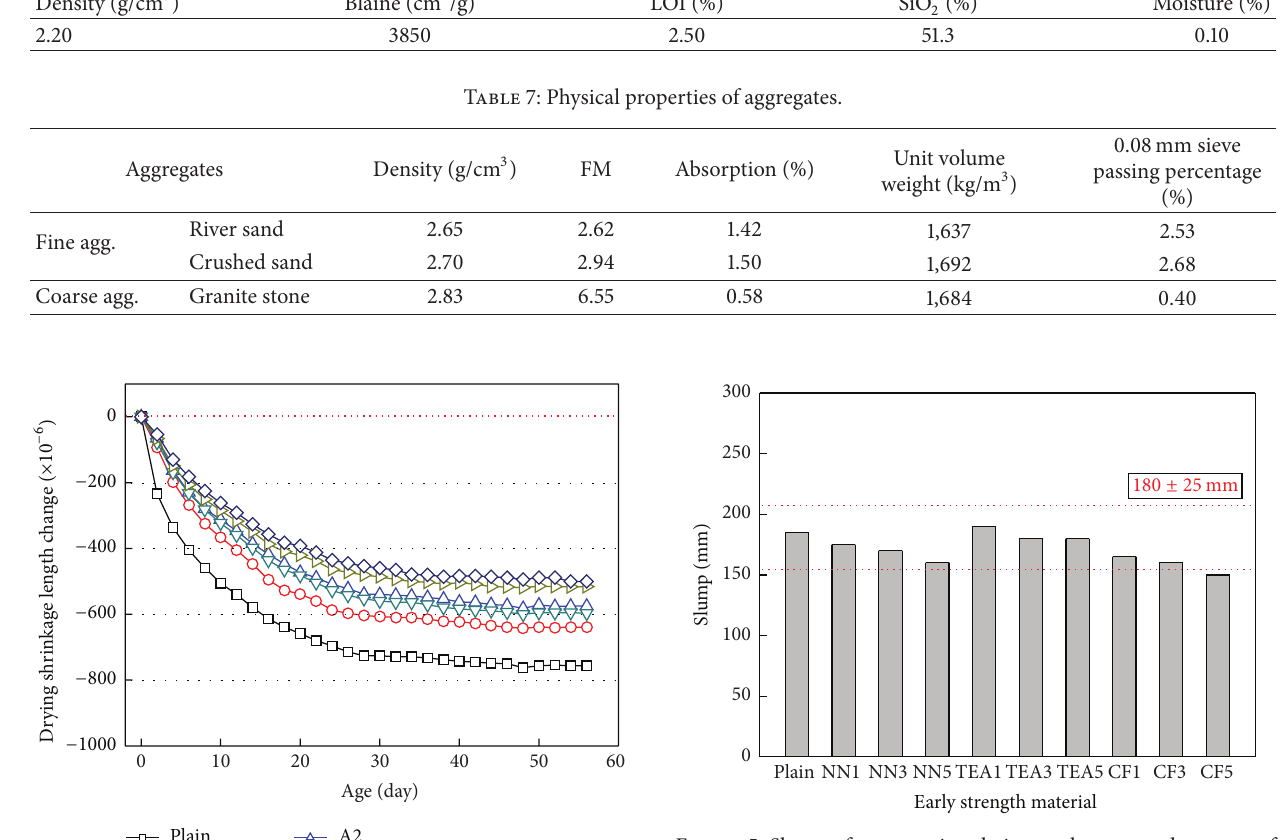
Figure 5: Slump of concrete in relation to the type and amount of early strength